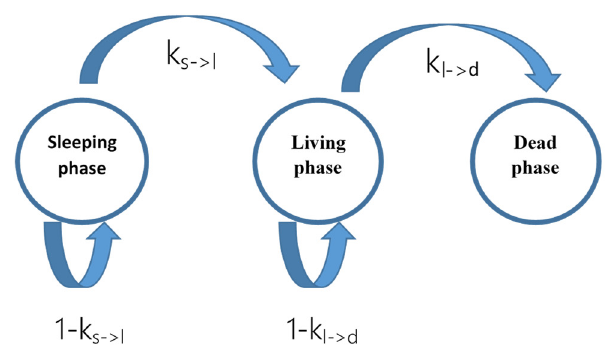
Figure 4. Graphical representation of the Markov model for the aging model.